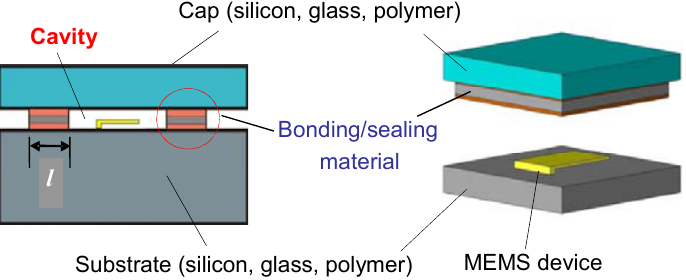
Figure 1. Schematic illustration of a MEMS package and the length of the leak channel,